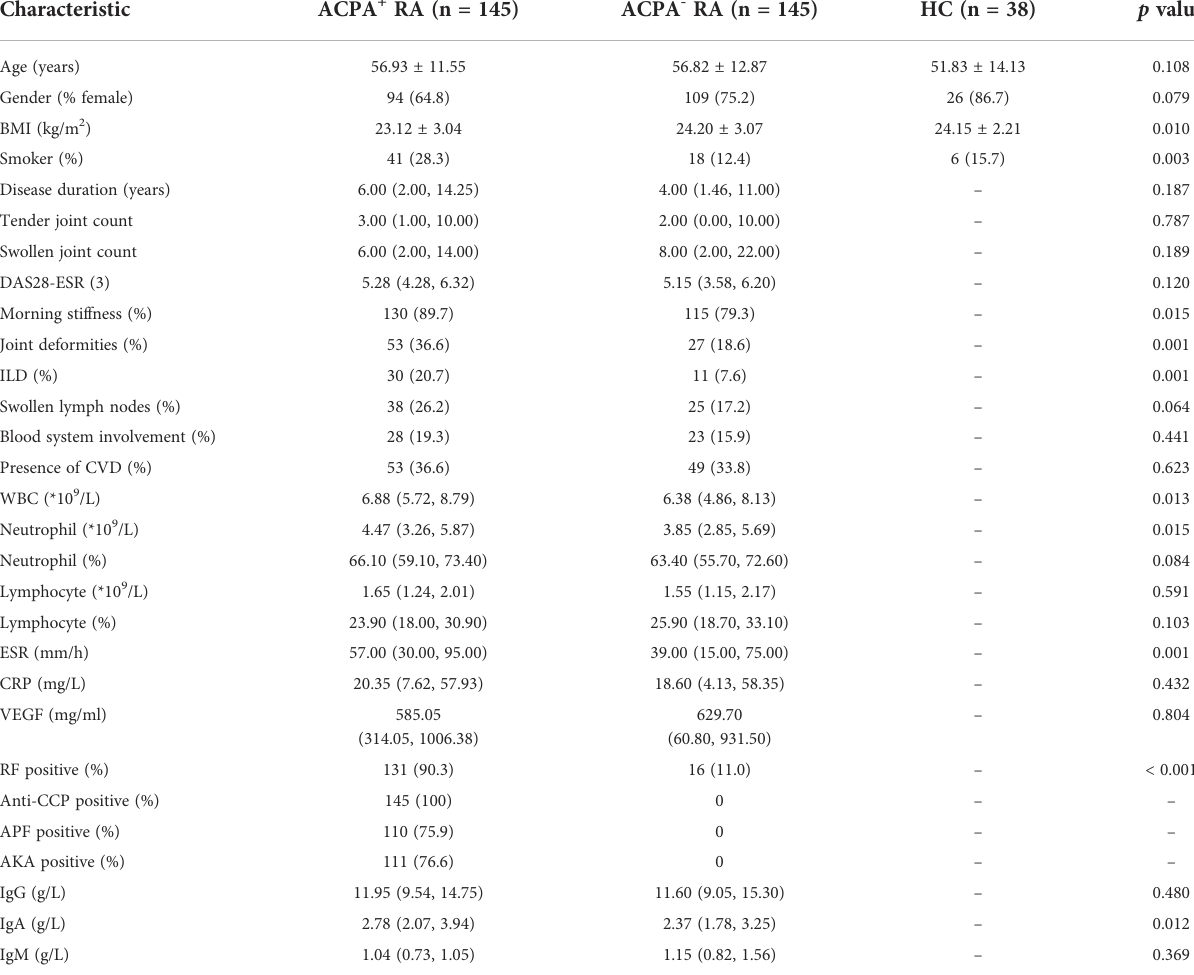
TABLE 1 Demographic characteristics and laboratory values between ACPA + RA, ACPA - RA patients and healthy controls.